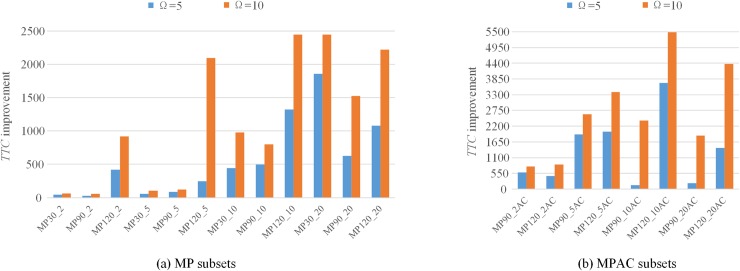
Comparison of TTC improvements of MP subsets and MPAC subsets.